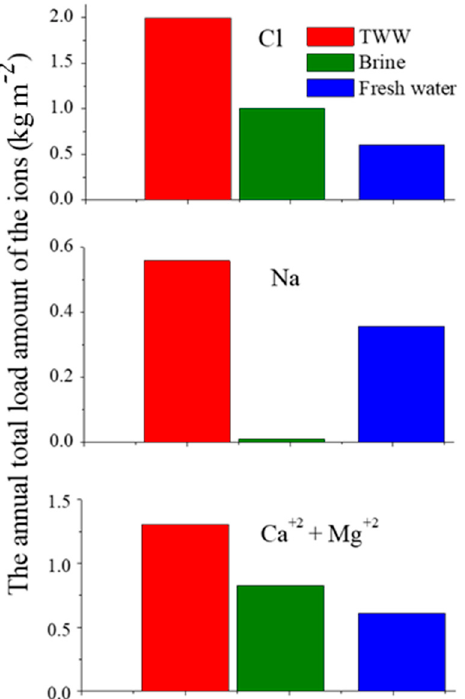
Figure 4. The annual loaded amounts ( P j ) of Cl (upper part), Na (middle part), or Ca+Mg (bottom part), on the unpaved roads following the treated wastewater (TWW), brine and fresh water (FW) applications (the Y-axes’ scales are